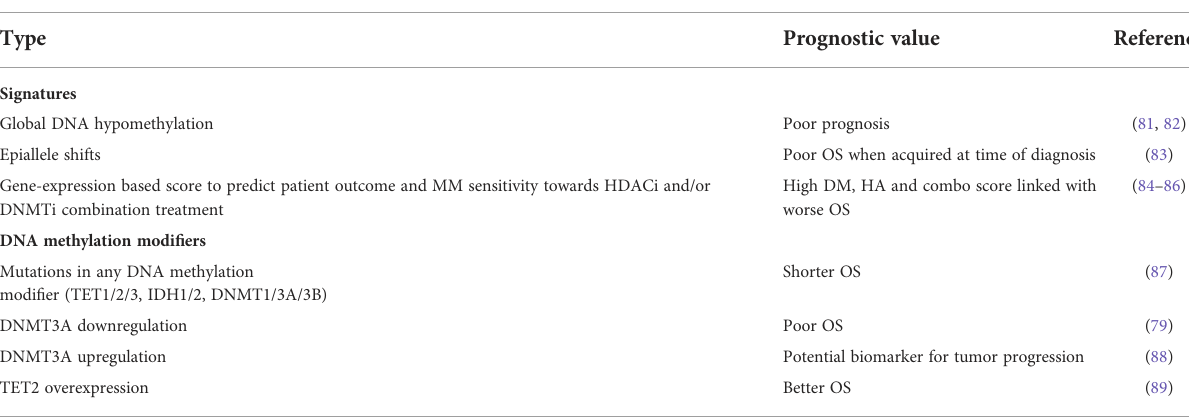
TABLE 2 Potential biomarkers in MM based on MM signatures and DNA methylation modi fi